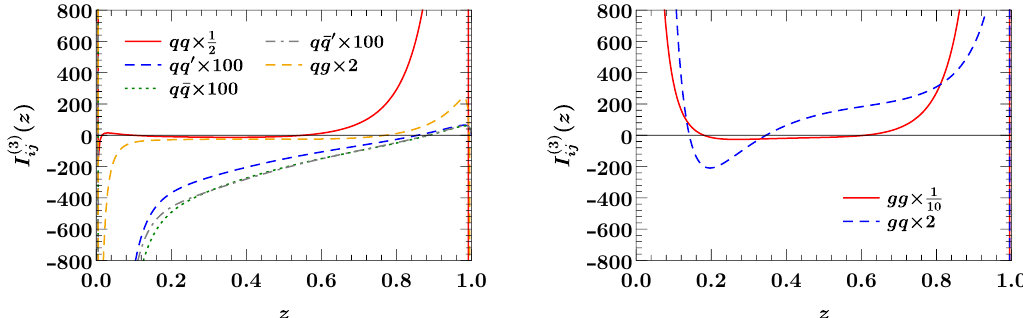
Figure 1 . The N 3 LO boundary term I (3) as a function of z in all channels contributing to the ij quark beam function (left) and the gluon beam function (right). The di(cid:11)erent channels are rescaled as indicated in the